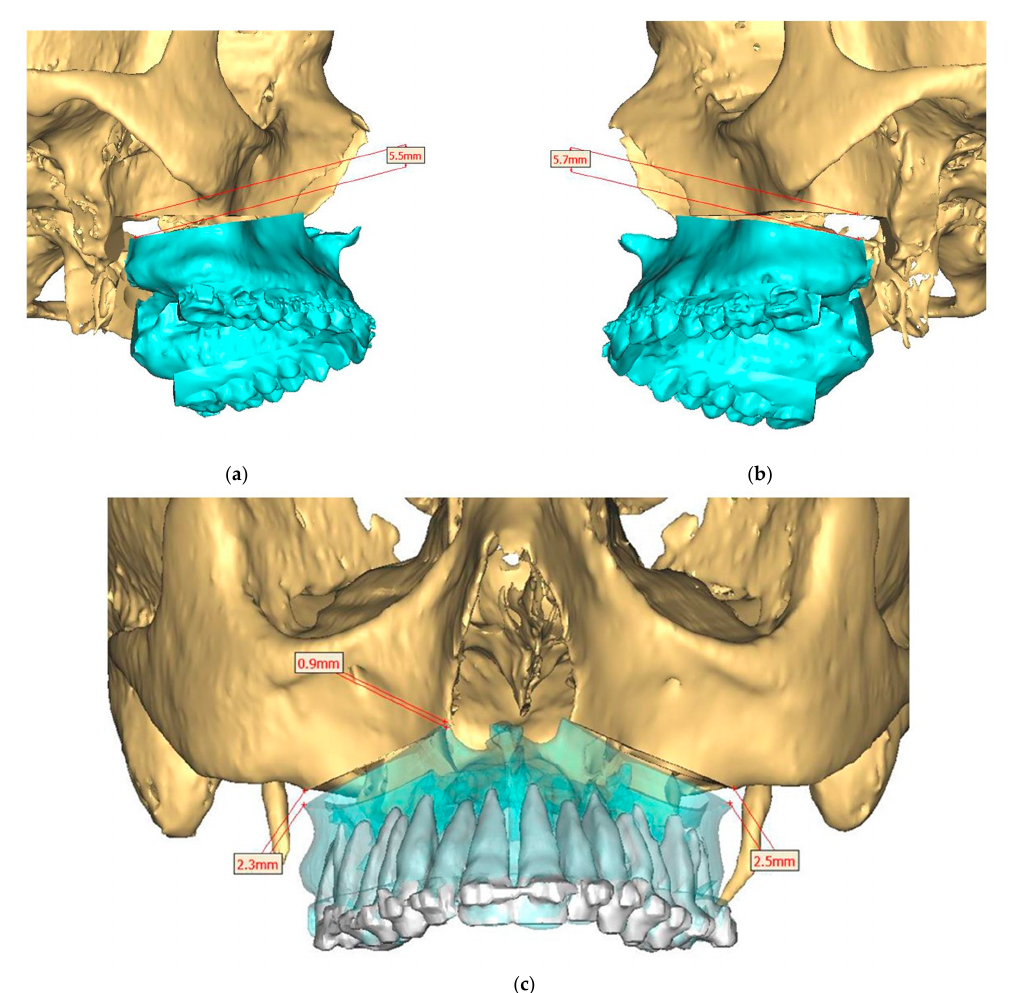
Figure 3. Surgical Plan: Final Position—Mandible moved according to planned maxilla position (Proximal segments rotated in) ( a ) Frontal view; ( b ) Occlusal view; ( c ) Right side view; ( d ) Left side view.